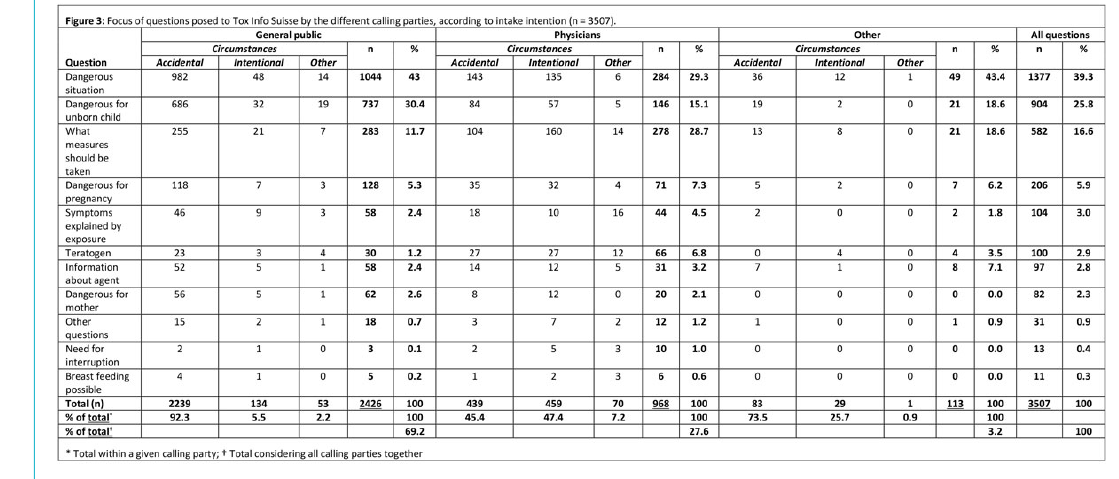
Figure 3: Focus of questions posed to Tox Info Suisse by the different calling parties, according to intake intention (n =